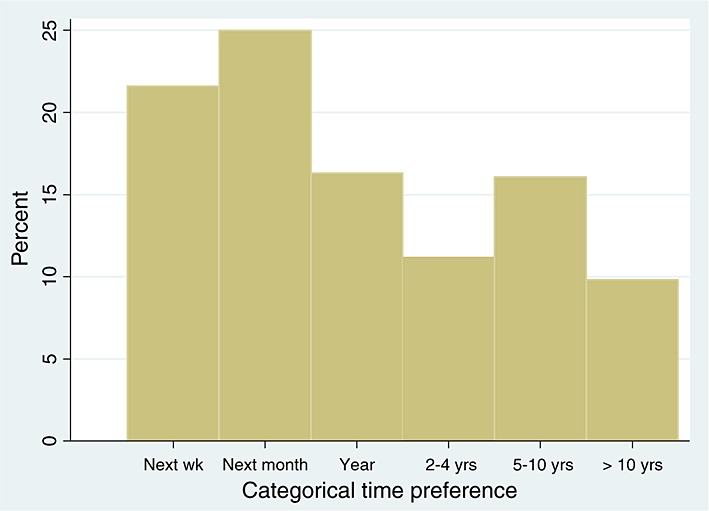
Distribution of time preference for mothers